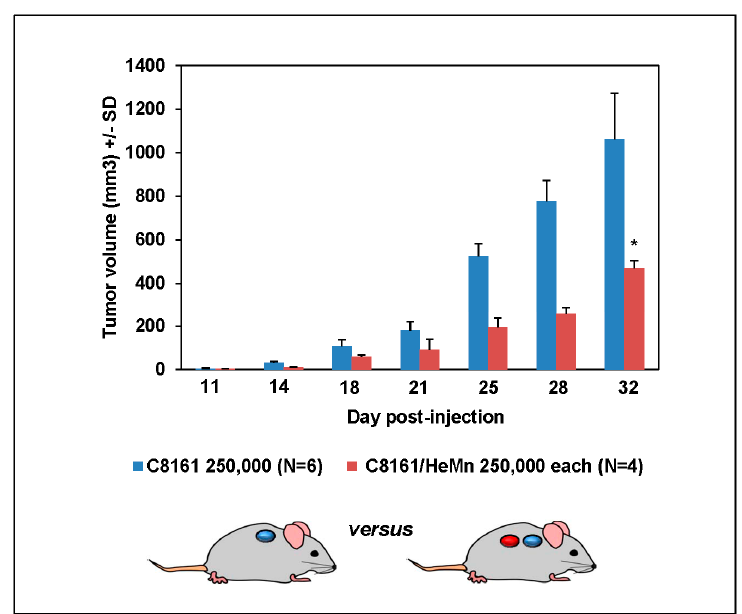
Figure 2. Growth of C8161 cells and HeMn melanocytes in Nude mice. At the end of the observation period, final tumor volume formed from the initial 250,000 human melanoma C8161 cells was significantly reduced when grown in close proximity to 250,000 HeMn melanocytes, compared to the final tumor volume of 250,000 C8161 allowed to grow alone (* p < 0.001).